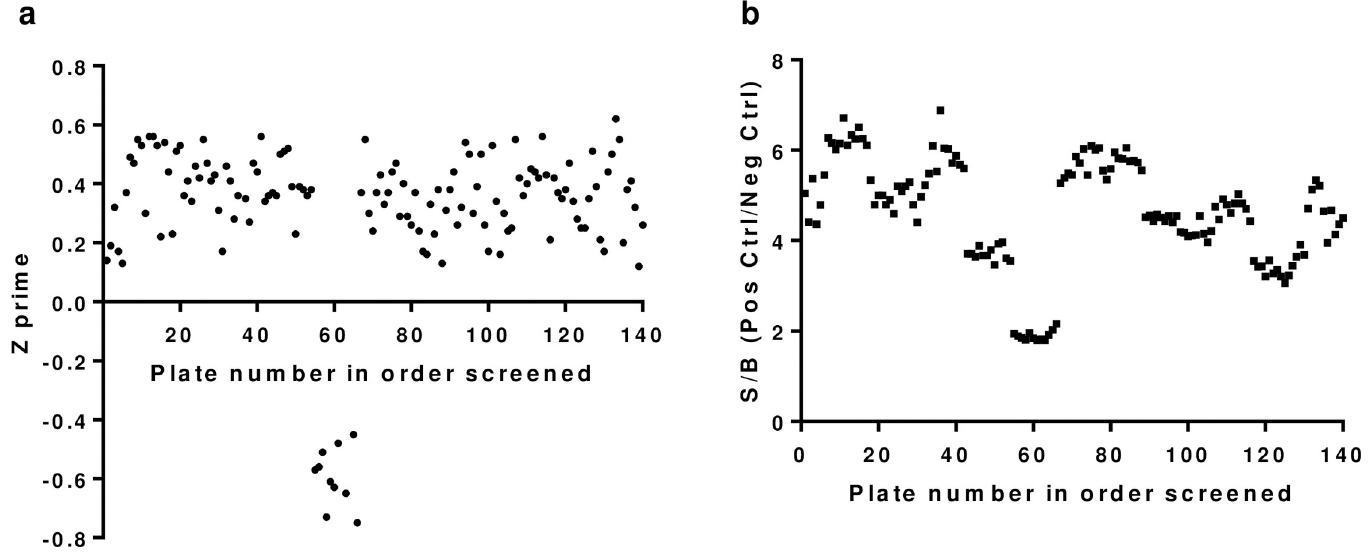
Fig 2. Primary screen quality. a. Z-prime value per assay plate screened. b. Signal/Background per assay plate screened.